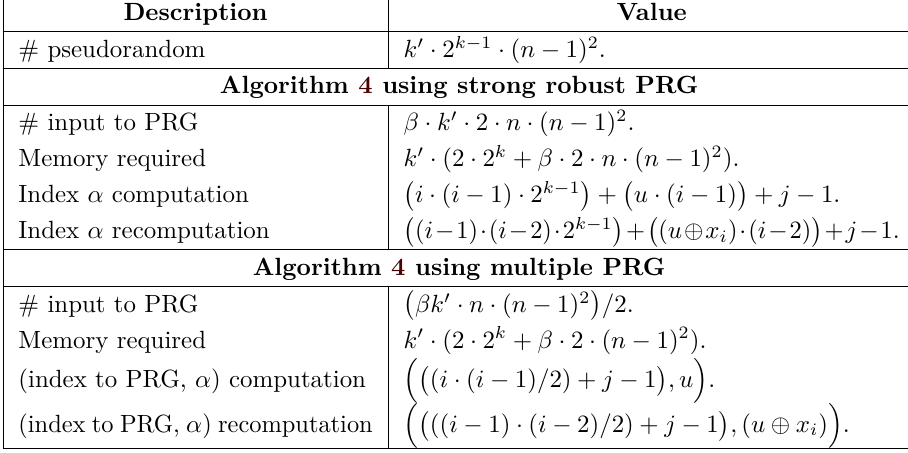
Algorithm 4 using multiple